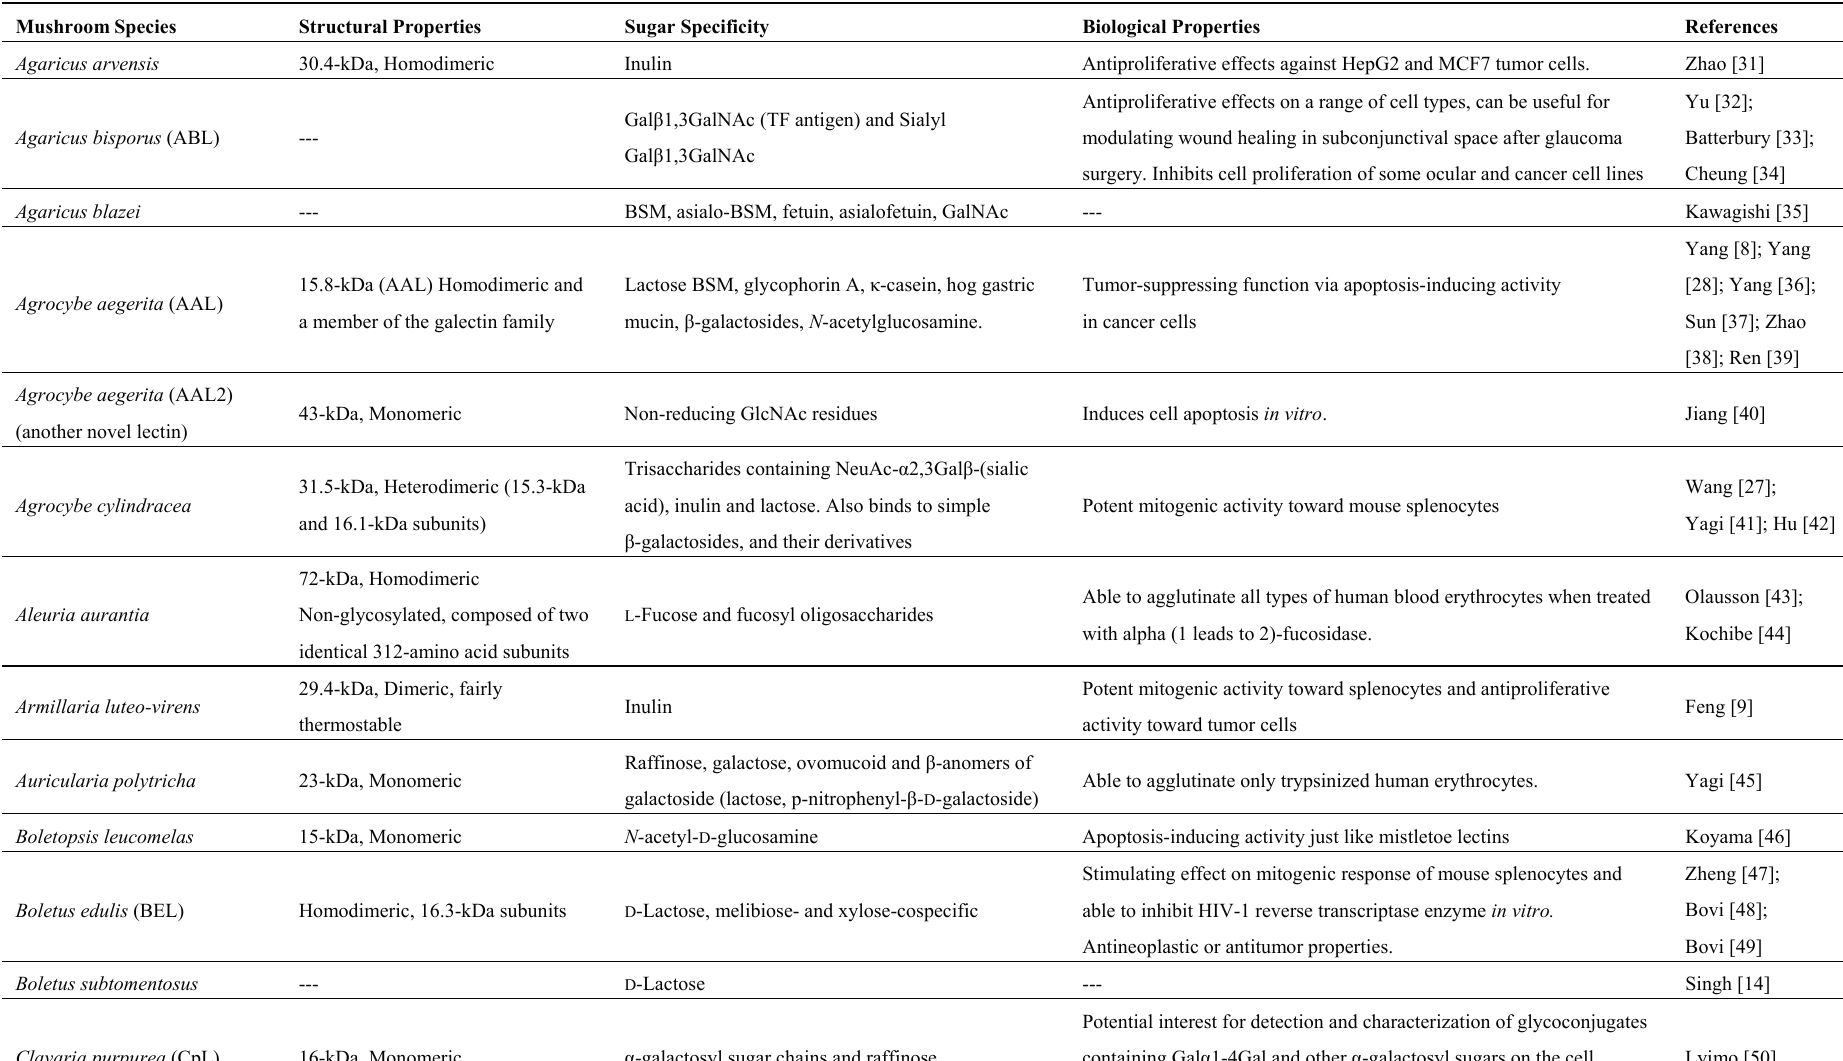
Table 1. Structural and biological aspects of various reported lectins from edible